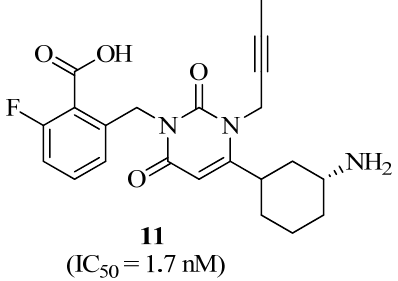
Figure 7. Uracil derivative containing benzoic acid as DPP-IV inhibitor.